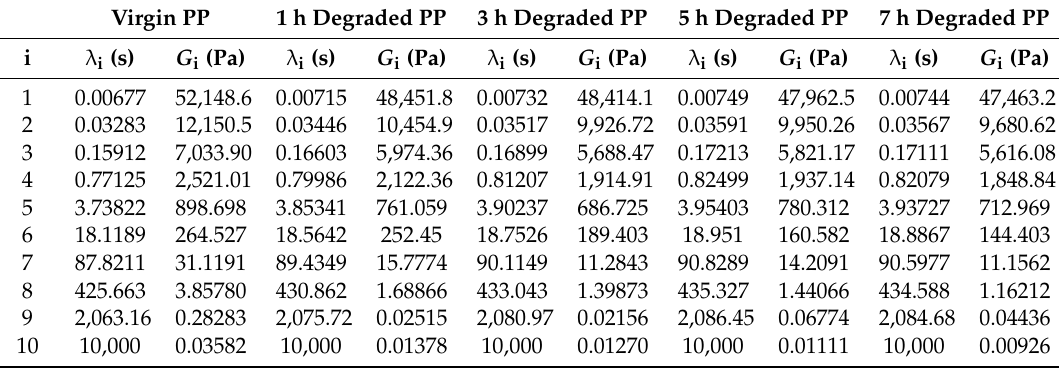
Table 1. Maxwell model parameters for all tested polymer samples at T = 180 ◦ C.